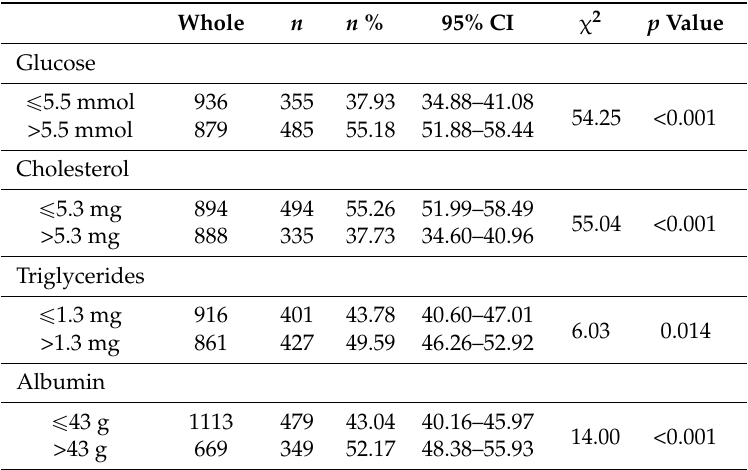
Table 4. Prevalence of hypertension and associations with blood factors.